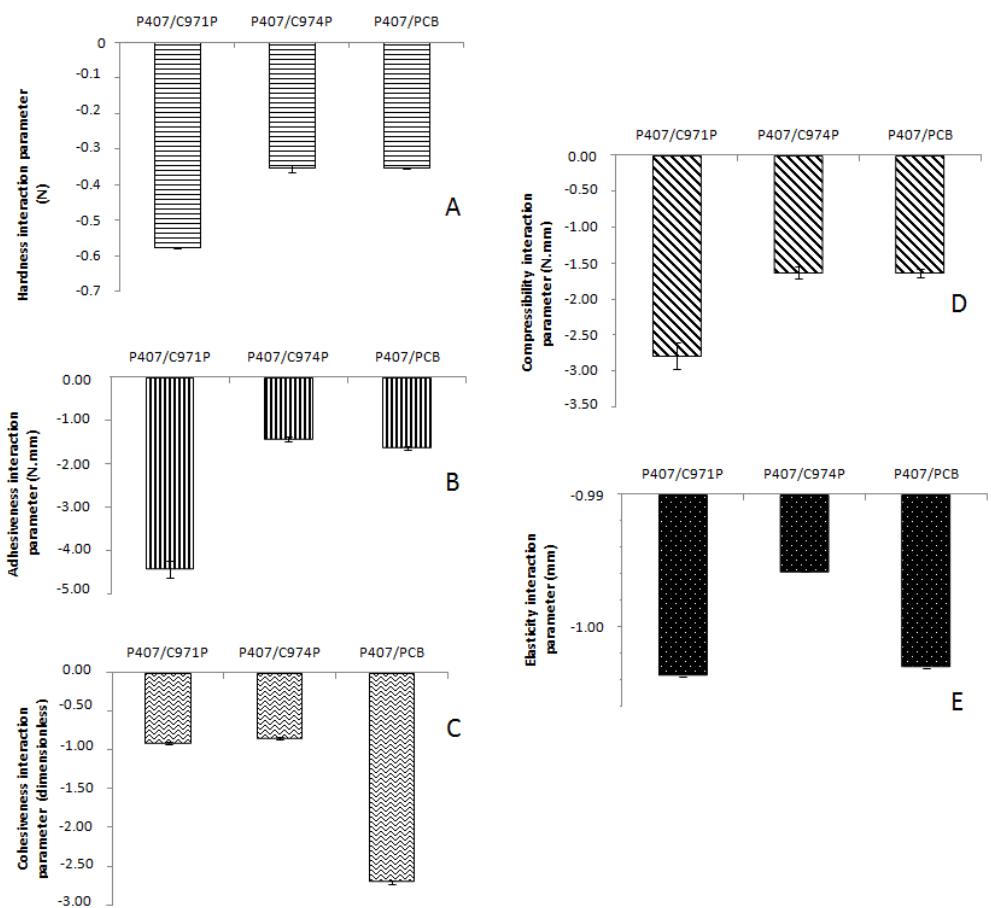
Figure 6. Mechanical properties obtained by texture profile analysis (TPA) of the polymeric systems containing poloxamer 407 (P407), mucin and Carbopol 971P ® (C971P), Carbopol 974P ® (C974P) or Noveon ® Polycarbophil (PCB) and of pure mucin solution: ( A ) hardness, ( B ) adhesiveness, ( C ) cohesiveness, ( D ) compressibility, ( E ) elasticity.